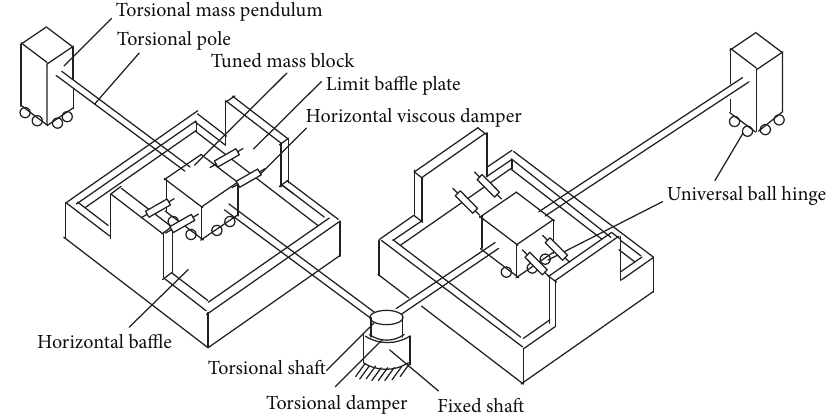
Figure 1: Composition of the